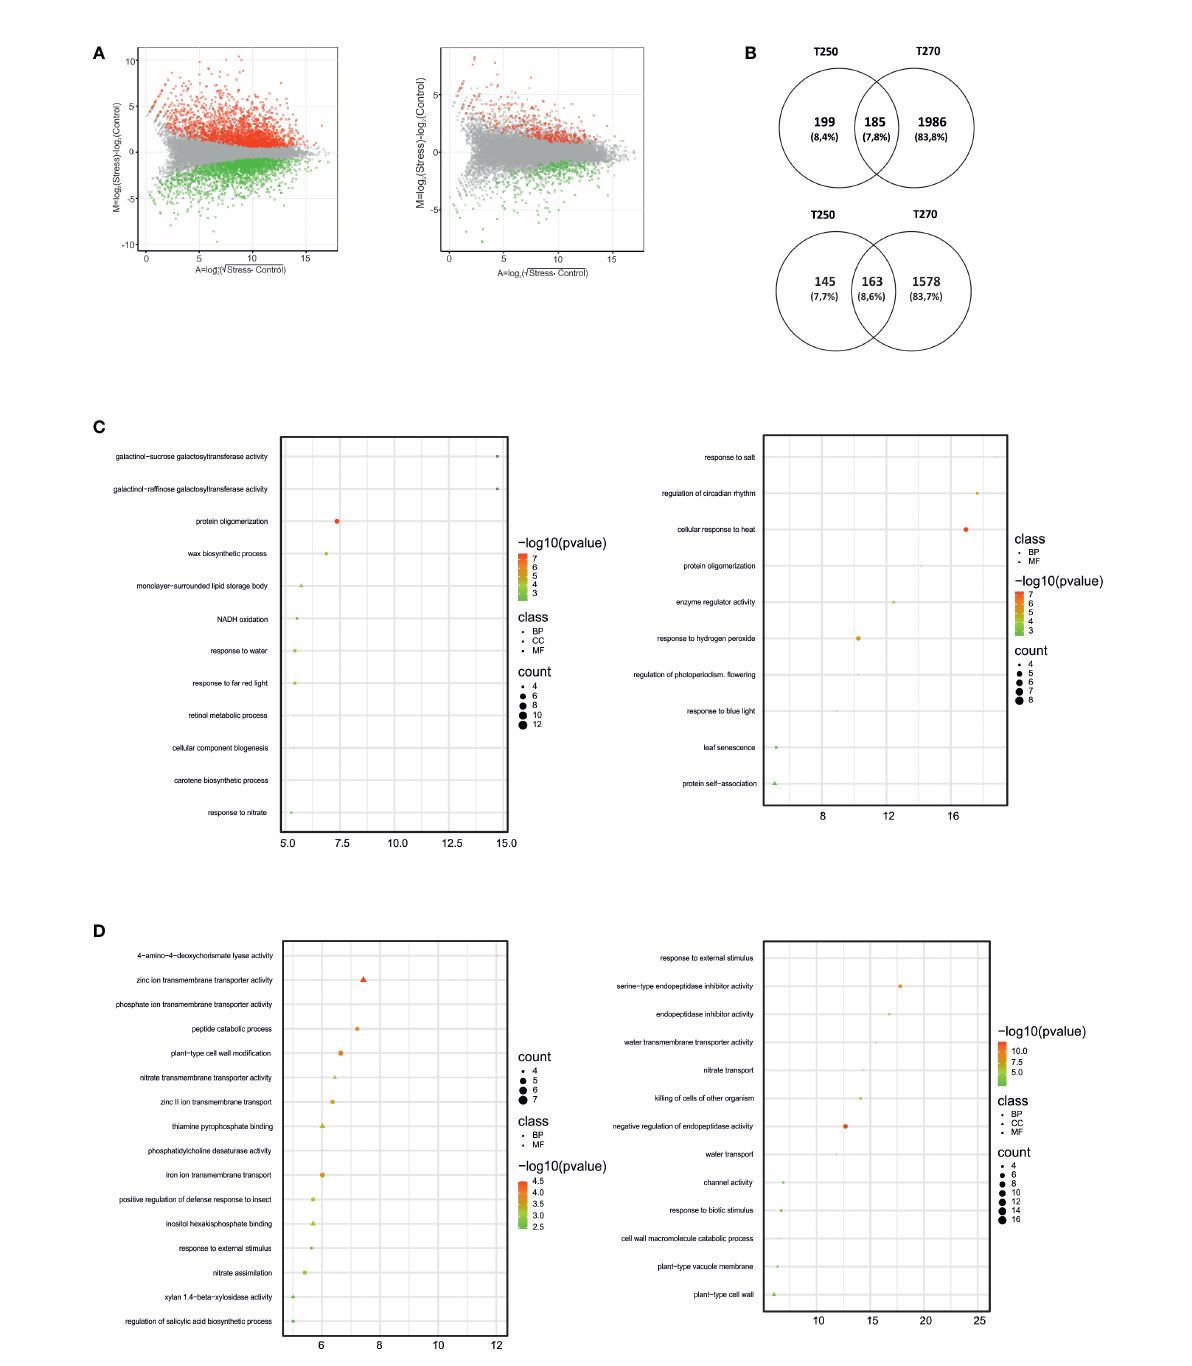
FIGURE 5 Differentially expressed genes (DEGs) and enriched Gene Ontology terms in roots of T250 and T270 subjected to combined stress. (A) MA plots depicting the distribution of DEGs (green dots, down-regulated, red dots, up-regulated) in T270 (left) and T250 (right) roots. X-axis: log 2 mean expression across treatments; Y-axis: log 2 expression fold change in combined stress vs. control treatments. (B) Venn diagrams depicting number and overlap of up-regulated (upper panel) and down-regulated (lower panel) DEGs in roots of combined stress-treated T250 and T270. The diagrams were drawn using the online tool Venny (Oliveros, 2007-2015); (C, D) Plots showing enriched GO terms in root DEGs up (C) or down-regulated (D) in T270 (left) or T250 (right). Symbols indicate GO categories: MF, Molecular Function; CC, cellular compartment, BP, biological process. Symbol sizes are proportional to the gene count, whereas colors represent FDR values< 0.05. X-axis: enrichment score. Categories with ES> 5 and gene count > 4 are